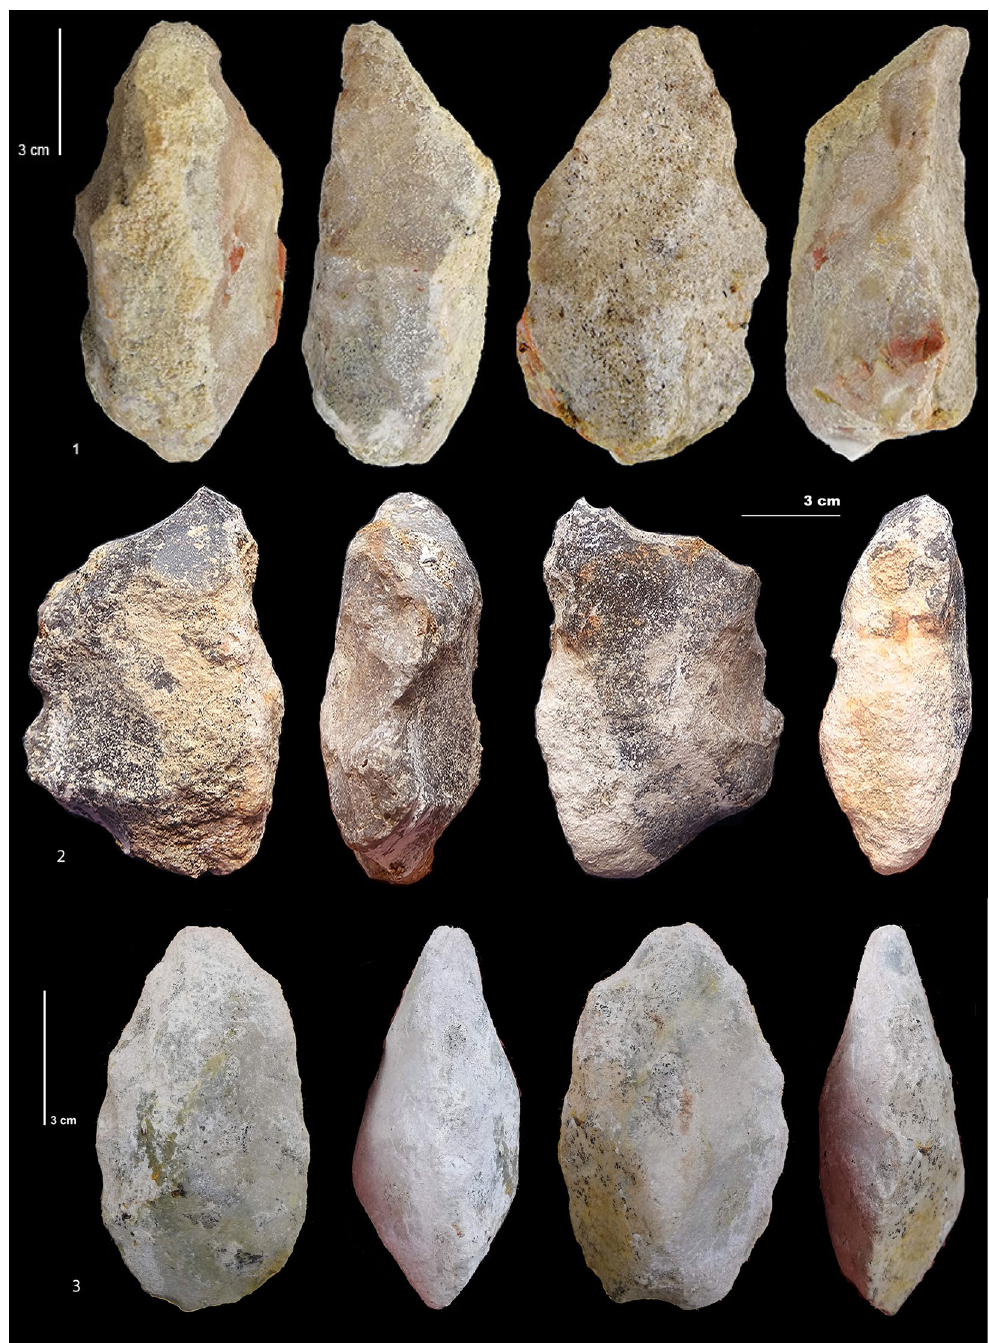
Figure 6. Layer G. ( 1 ) Recycled bifacial or trifacial tool on a limestone pebble. ( 2 ) Bifacial tool on a large chert nodule. ( 3 ) Biface on limestone pebble. Two limestone bifaces were also discovered in layer G, including one recycled specimen. As with the bifaces of layer F, they demonstrate a bifacial volume management and equilibrium of the two faces of the tool, as for the tools of layer F. The n° 1 shows a triface/biface on a pebble. It is a recycled tool with centripetal smooth removals on one flat face (lower face). The second phase of shaping used the piece as a preform to shape the opposite face by abrupt and more or less invasive removals on both lateral edges and the proximal extremity. There are crushing marks on the round tip, which is slightly shaped. The second biface is also on a pebble (n° 3 ). Shaping is alternate managing the whole volume by invasive and small removals to create a symmetrical tool. The shape is symmetrical. There is also one bifacial tool on a large chert nodule (n° 2 ). Using the natural shape of the nodule, the shaping is made by bifacial invasive convergent removals on one side and the proximal part form a tool that is asymmetrical in shape and cross-section, preserving a back on the opposite side. A back is preserved on the opposite side. There is with a notch related to a bec at the tool extremity. Detailed descriptions are given in the Supplementary data. (Photos M-H. Moncel, C.